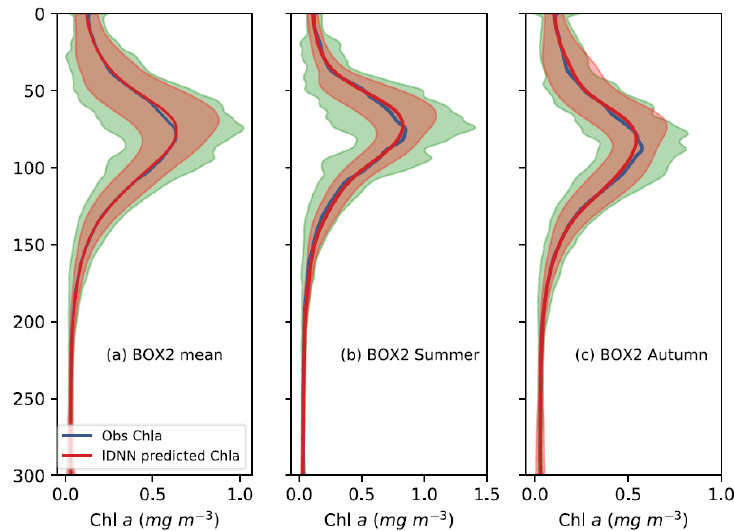
Figure A2. Aggregated chlorophyll vertical profiles from the test set in BOX2 during four seasons ( a ), during summer ( b ), and during autumn ( c ), after removing two profiles with extreme values (over 4 mg m − 3 ) between 0–50 m. The blue and red solid lines represent the mean of observed value and the mean of IDNN predicted Chl a , respectively. The pink and green shades are the standard variance of the model results and observations, respectively, which overlap and form the brown shade.